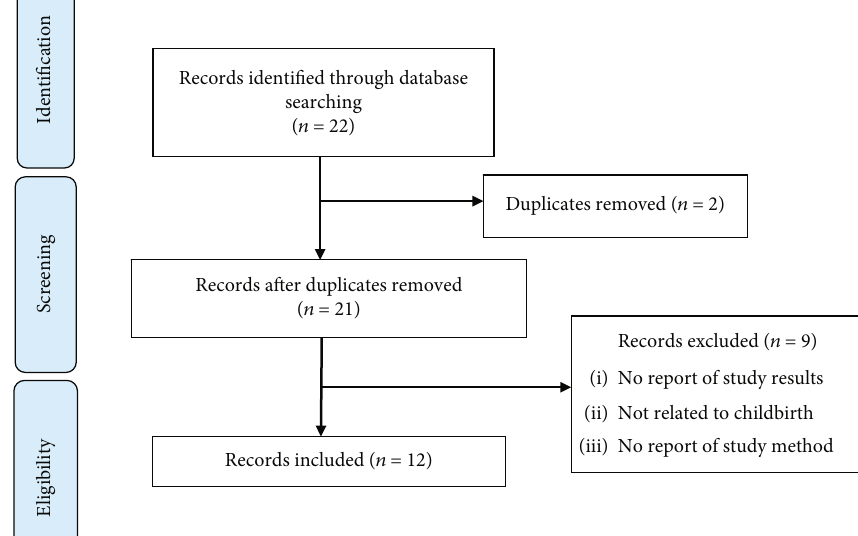
Figure 1: The articles included in the